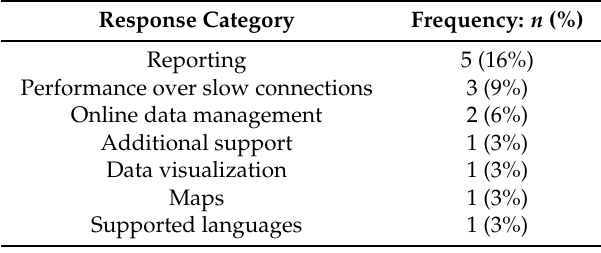
Table 10. Most important dashboard